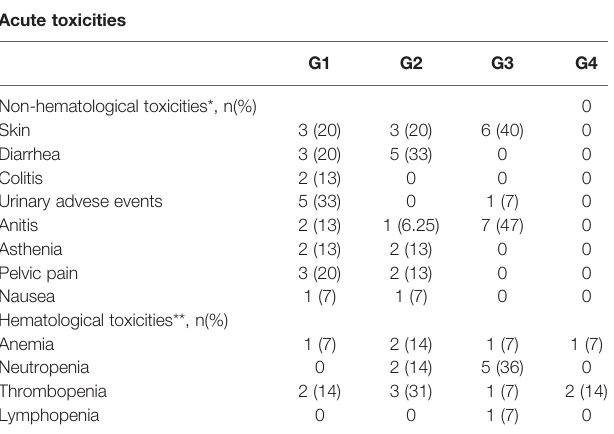
FIGURE 1 | Local progression-free survival.